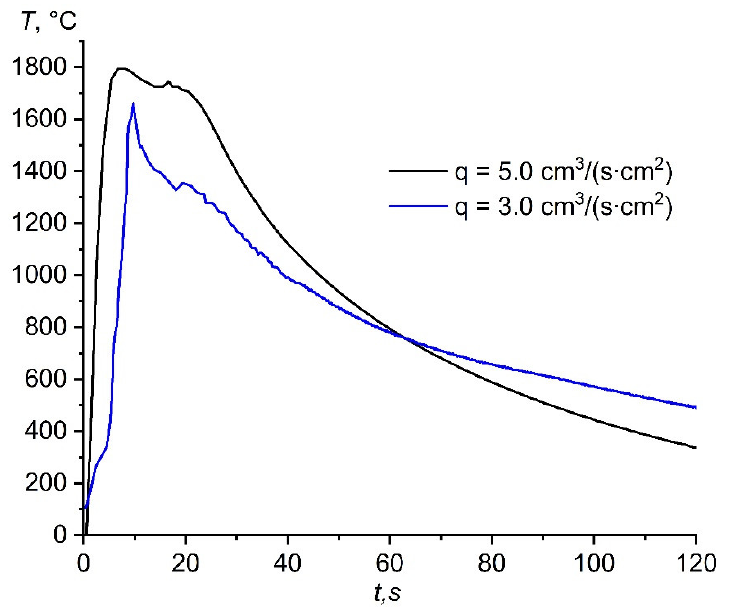
Figure 7. Heat patterns obtained during the combustion of the (70% AlN+ 30% Al) samples in the flow of the nitrogen–argon mixture.